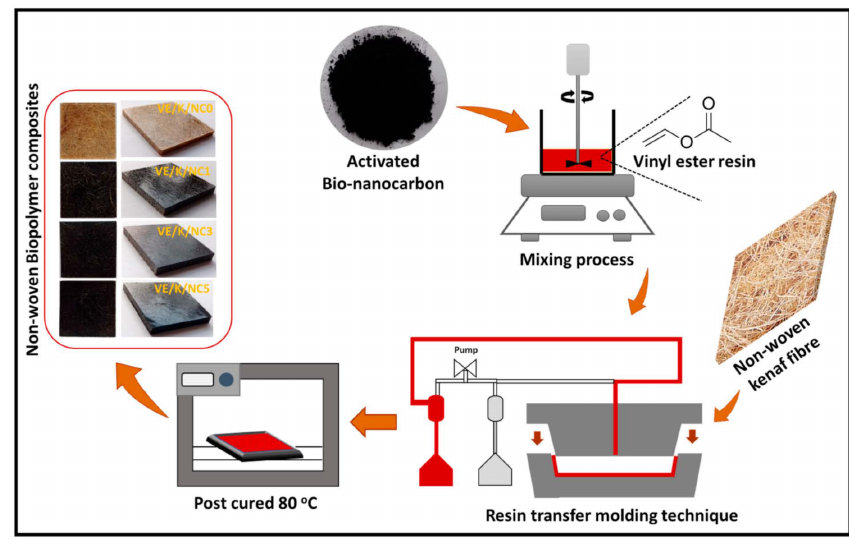
Figure 1. Schematic flow diagram of the nanocomposites’